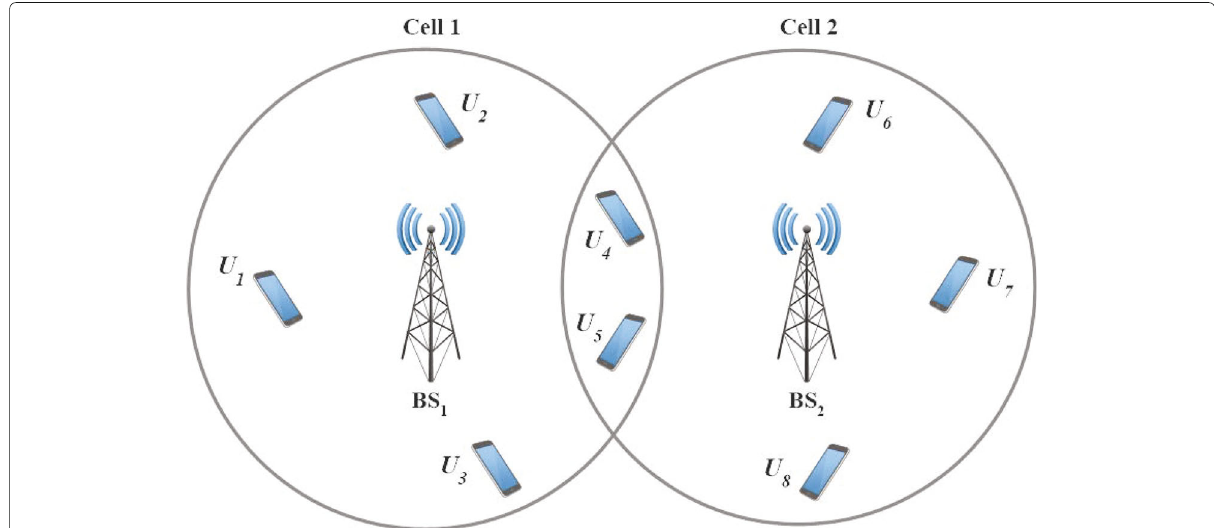
Fig. 1 A downlink multi-cell NOMA network with Q = 2 base stations and N = 8 users